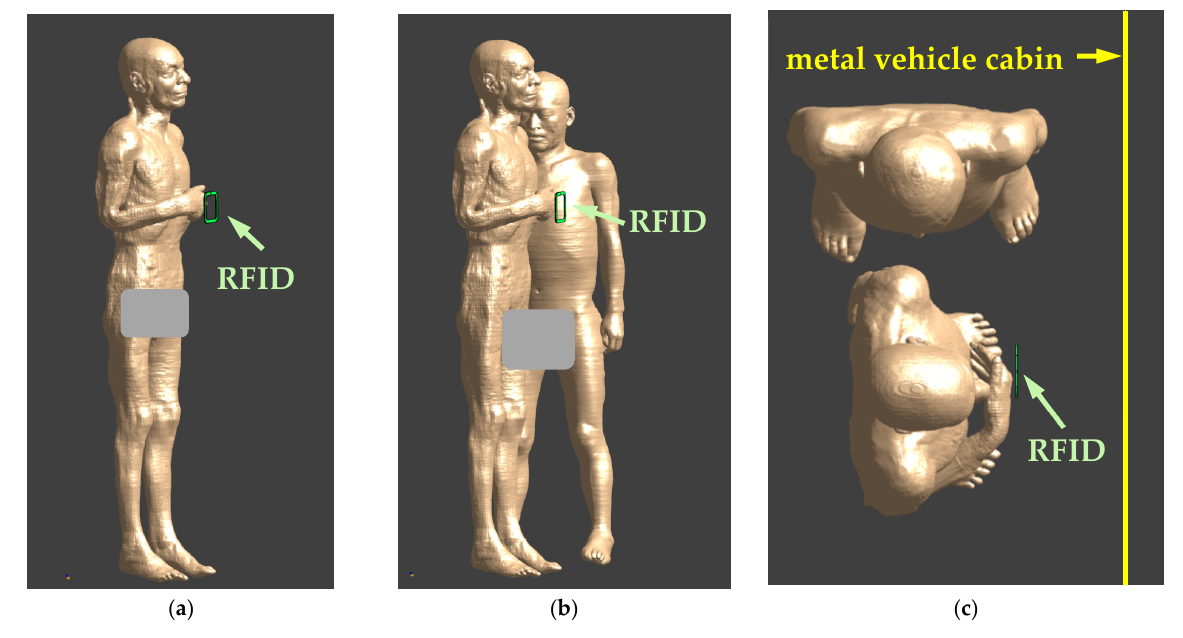
Figure 4. Exposure scenarios to EMF near HF RFID readers used in public transport vehicles: ( a ) side view of a person using the PICC device—reader on a vertical column; ( b ) side view of a person using the PICC device and a bystander (person standing nearby)—reader on a vertical column; ( c ) top view of a person using the PICC device and a bystander—reader attached to a vehicle cabin (the positions of the HF RFID readers are marked with arrows).